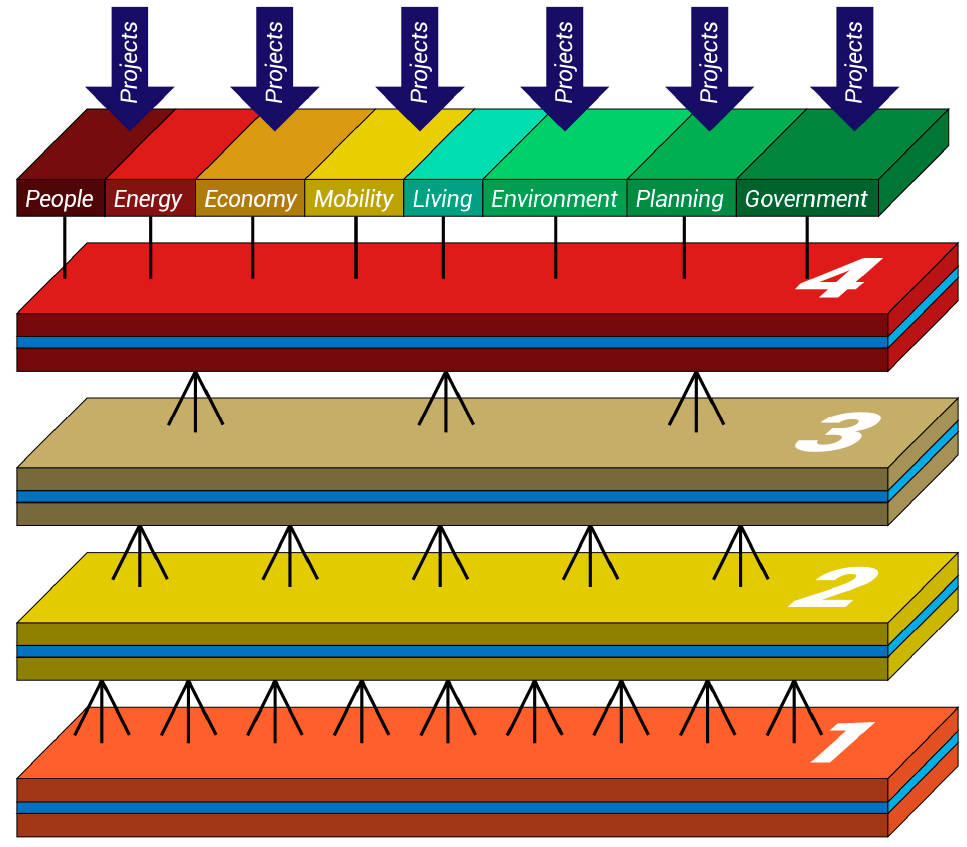
Figure 4. Smart program management in a Smart city.